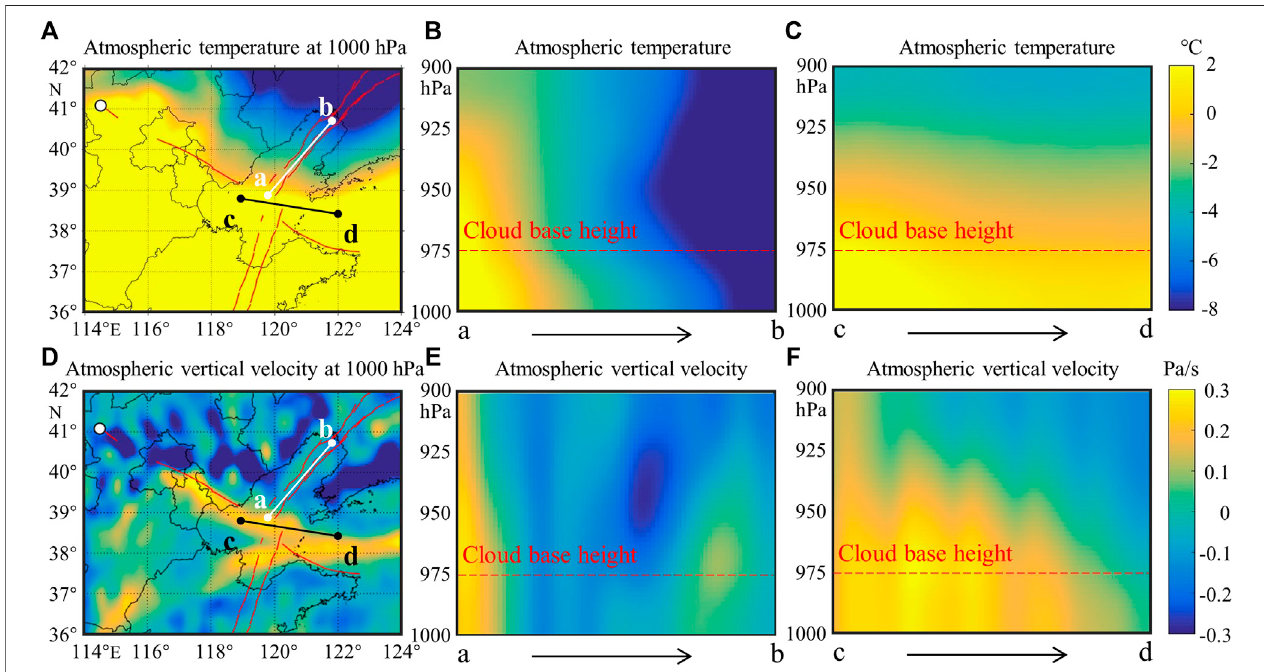
FIGURE 12 | Atmospheric temperature (A – C) and atmospheric vertical velocity (D – F) over Bohai Sea at 20:00 on 9 January 1998. (A) The atmospheric temperature at 1000 hPa. (B) The atmospheric temperature in different pressure layers along TLF (a-b direction). (C) The atmospheric temperature in different pressure layers along ZBF (c-d direction). (D) The atmospheric vertical velocity at 1000 hPa. (E) The atmospheric vertical velocity in different pressure layers along TLF (a-b direction). (F) The atmospheric vertical velocity in different pressure layers along ZBF (c-d